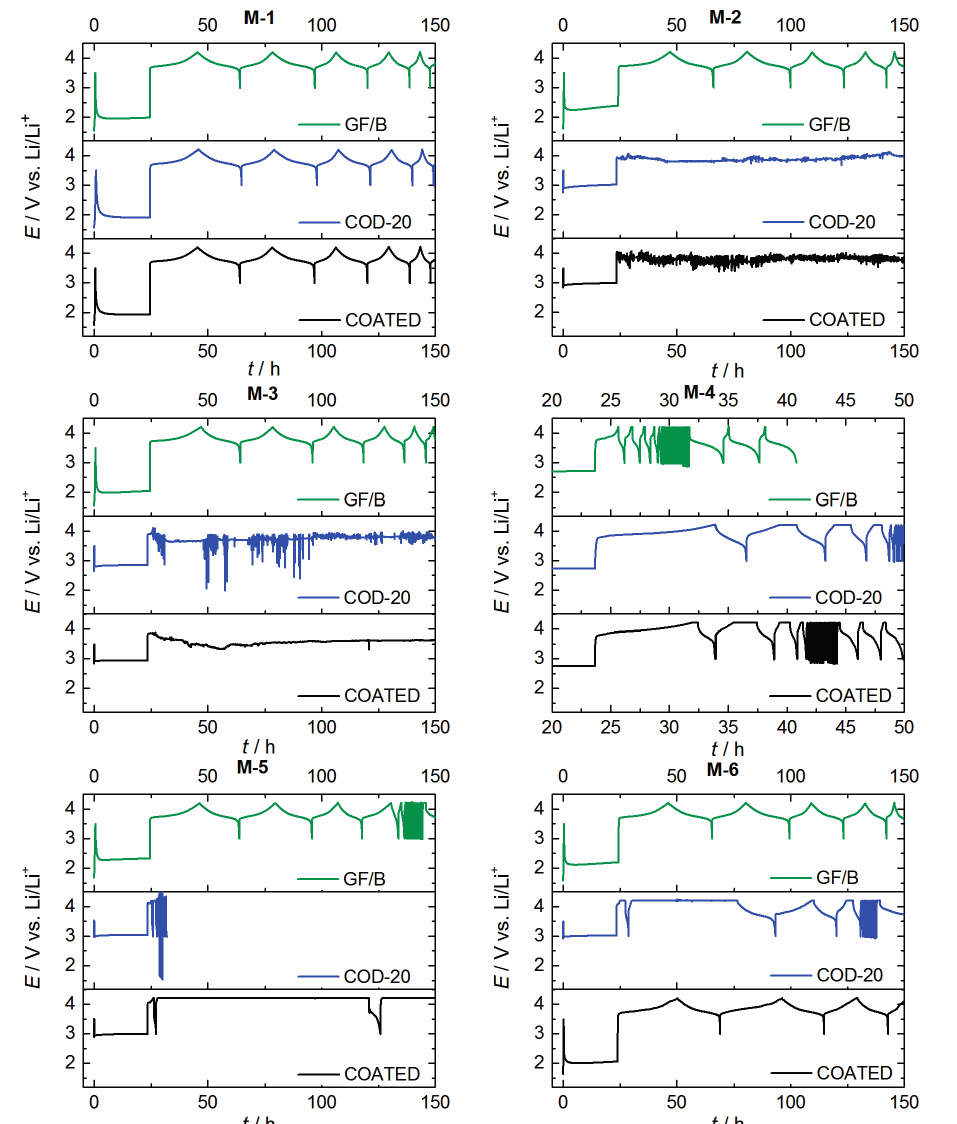
Figure 10. Cell cycling of NMC|Li (NMC = LiNi 1/3 Mn 1/3 Co 1/3 O 2 ) half cells with separator GF/B, COD-20 and COATED for each electrolyte mixture without additional